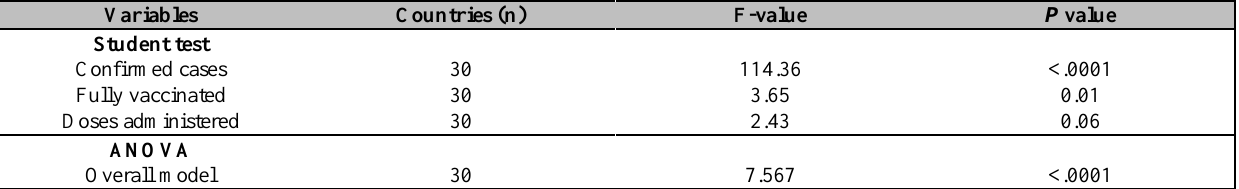
Table 2: Student and ANOVA tests to evaluate the effects of subregion and confirmed cases on deaths, subregion and fully vaccinated on deaths, subregion and doses administered on deaths. ANOVA evaluates the effects of subregions and the three